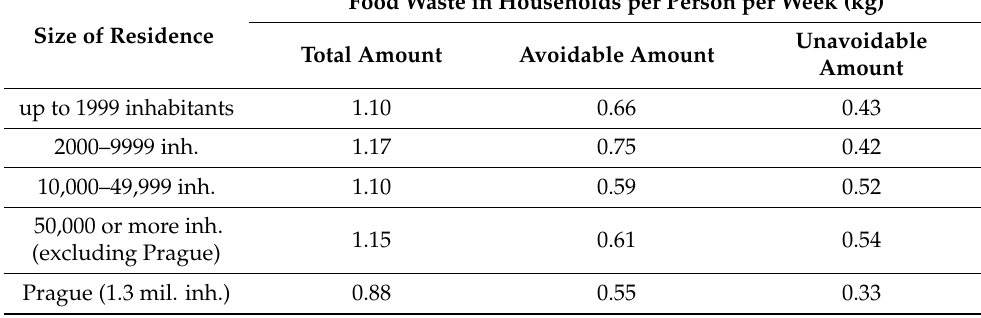
Table 5. Quantity of food waste by the residence